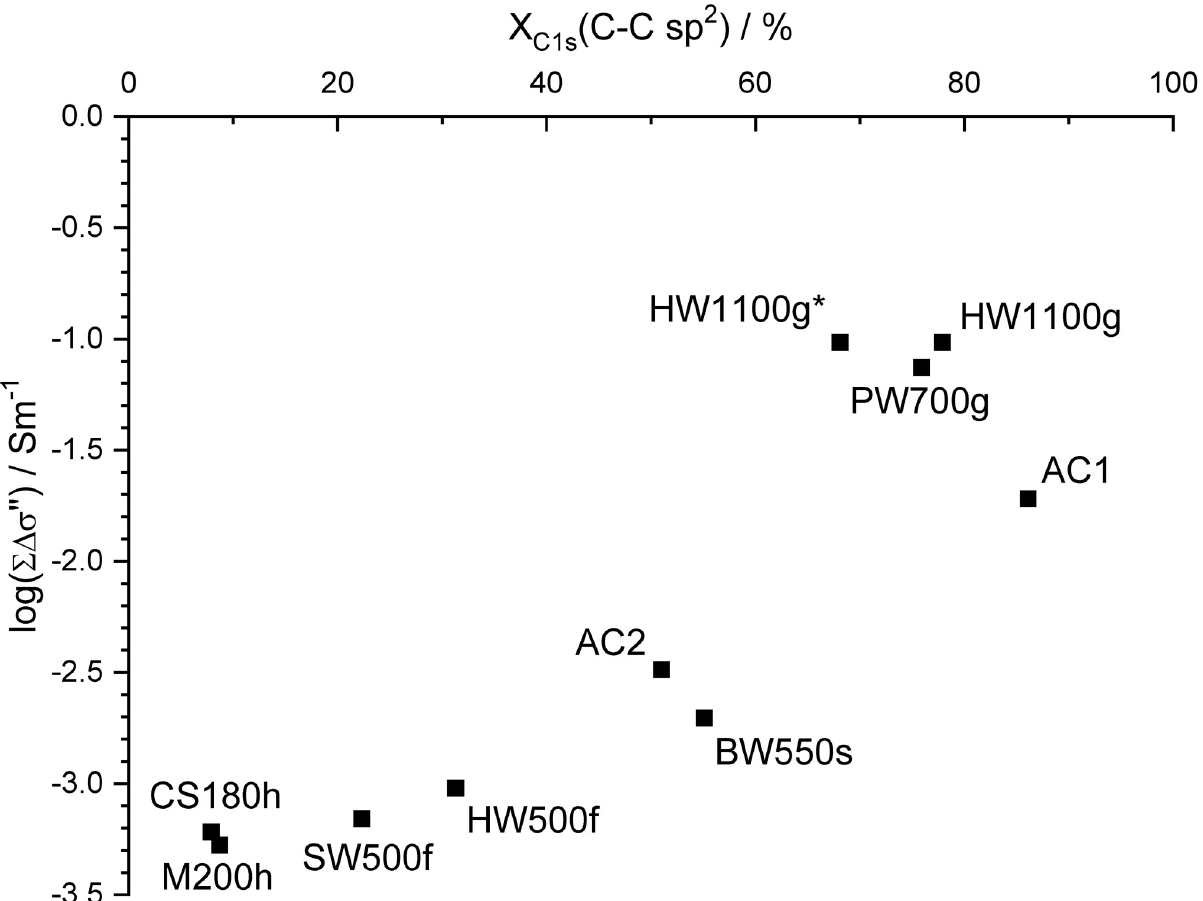
Fig 11. Plot of the logarithm of the sum of all measured imaginary values of the complex electrical conductivity against the fraction of sp 2 hybridized carbon.